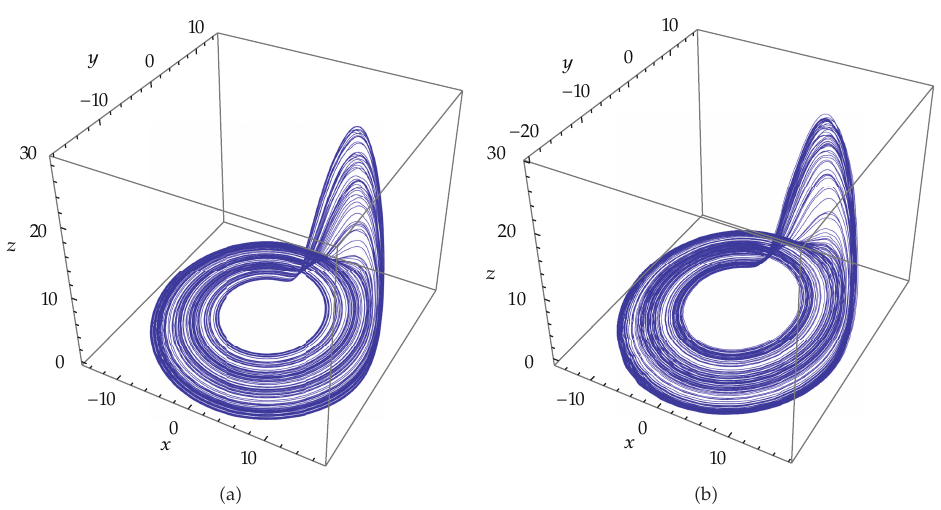
Figure 4: Phase plot of chaotic attractor in the x - y - z space, with a (cid:8) 0 . 15, b (cid:8) 0 . 2, c (cid:8) 10: (cid:3) a (cid:4) α 1 (cid:8) 0 . 71, α (cid:8) 0 . 66, α (cid:8) 0 . 71, (cid:3) b (cid:4) α (cid:8) 0 . 69, α (cid:8) 0 . 60, α (cid:8) 0 . 71. 2 3 1 2 3